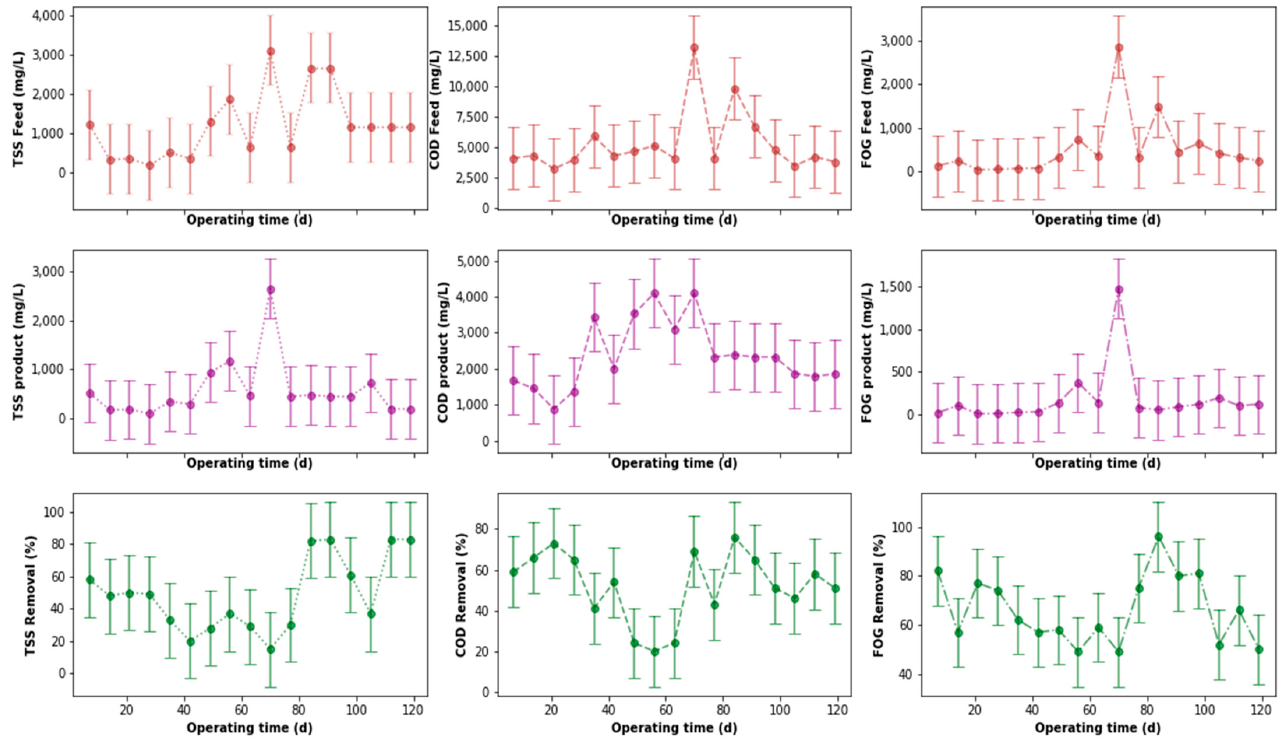
Figure 3. Pre-treatment performance before anomaly detection and Figure 3. Pre ‐ treatment performance before anomaly detection and correction.